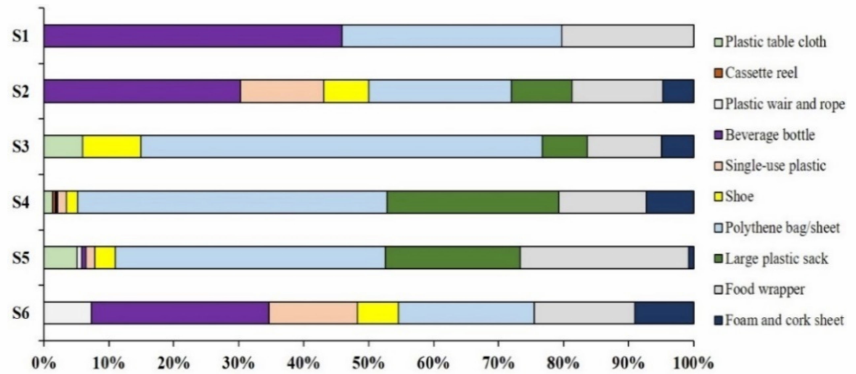
Figure 4. Proportions of different types of plastic items identified from study areas.